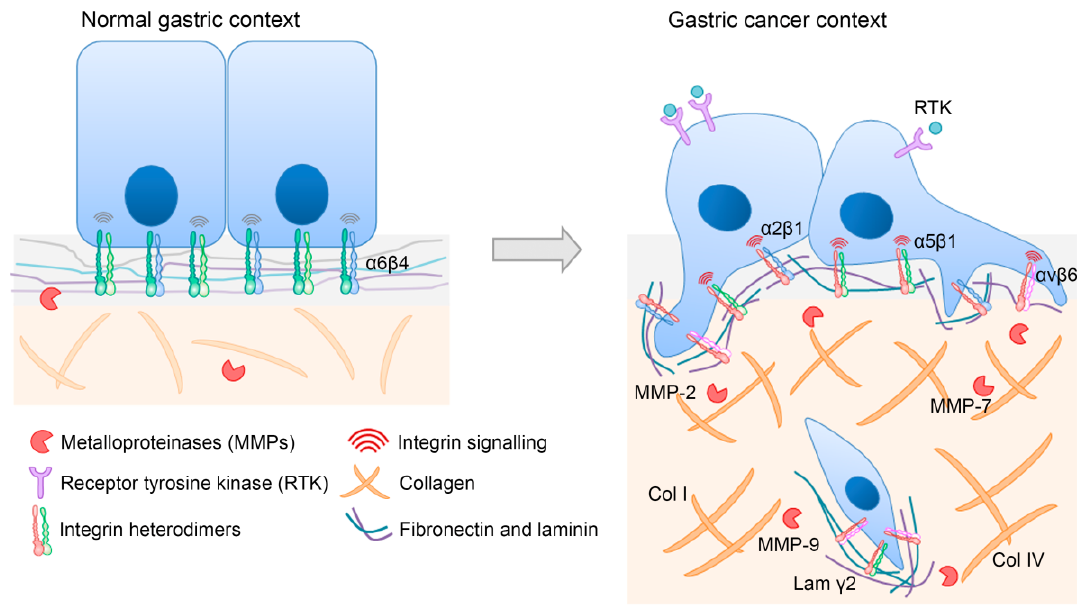
Figure 2. Representative image of major ECM-integrin alterations in gastric cancer. ECM composition, as well as integrin expression and signaling, are distinct in normal and in gastric cancer contexts. Relevant players for gastric carcinogenesis are depicted to illustrate aberrant features. Briefly, during gastric cancer development, the expression of some integrin heterodimers is lost ( α 6 β 4), whereas that of others is increased ( α 2 β 1, α 5 β 1, and α v β 6). Moreover, the increased activity of several MMPs (MMP-2, MMP-7, and MMP-9) is associated with cancer cell invasion. Increased levels of collagens (Col I and Col IV) and laminin γ 2 are also part of a specific gastric cancer ECM signature